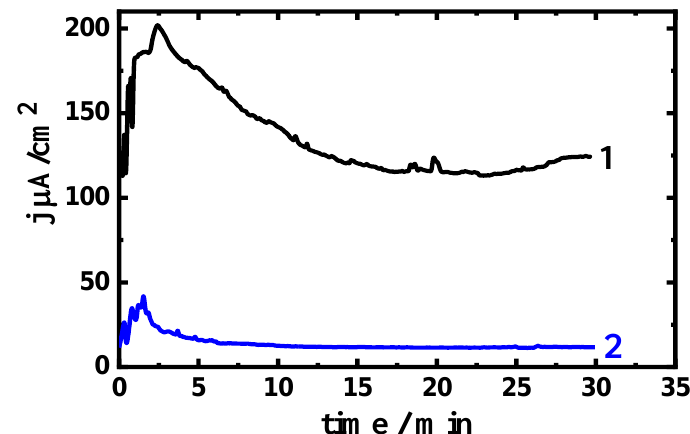
Figure 9. Change of current with time at 300 mV for (1) Ti-6%Al and (2) Ti-6%Al-4%V alloys after immersion in 3.5% NaCl solution for 1 h.